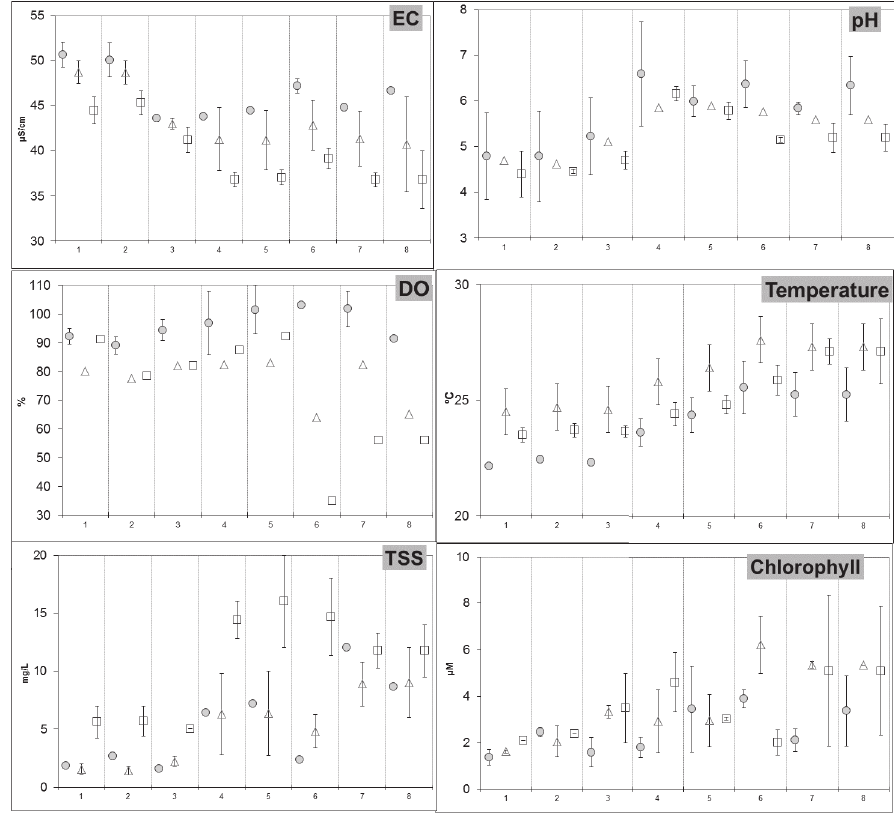
Figure 4 - Variation of electric conductivity (EC), pH, dissolved oxygen saturation (OD), temperature, total suspended solids (TSS) and chlorophyll at the eight stations, related to dry (circles), intermediate (triangles) and wet (squares) periods. Averages and standard error for each sampling point.